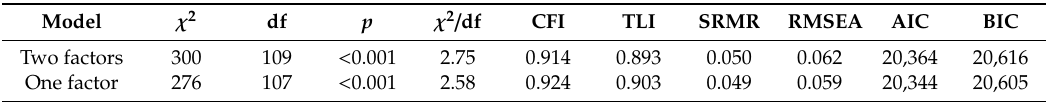
Table 3. Fit indexes of the original factorial structure of the Child and Youth Resilience Measure (CYRM-R) compared to those of the single-factor